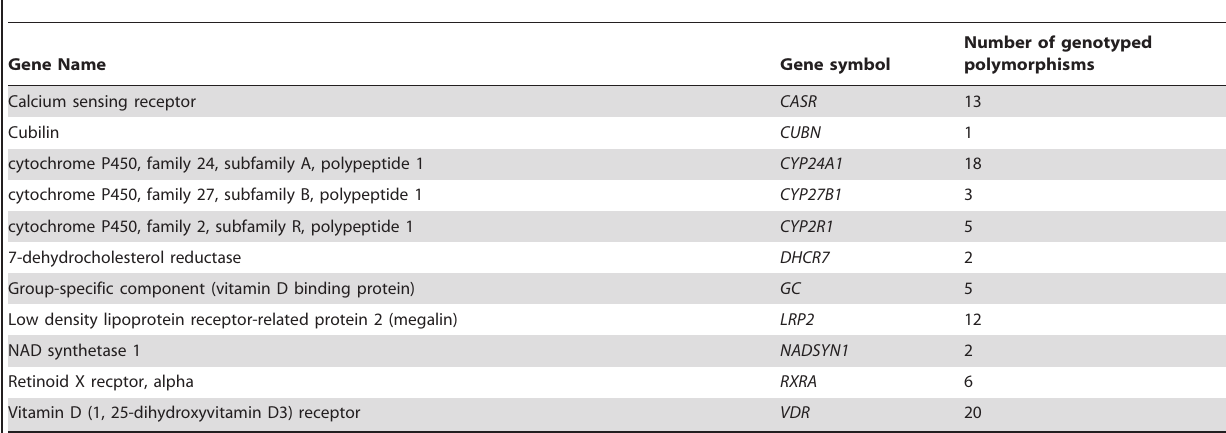
Table 1. List of vitamin D pathway genes, official gene symbols and number of polymorphisms